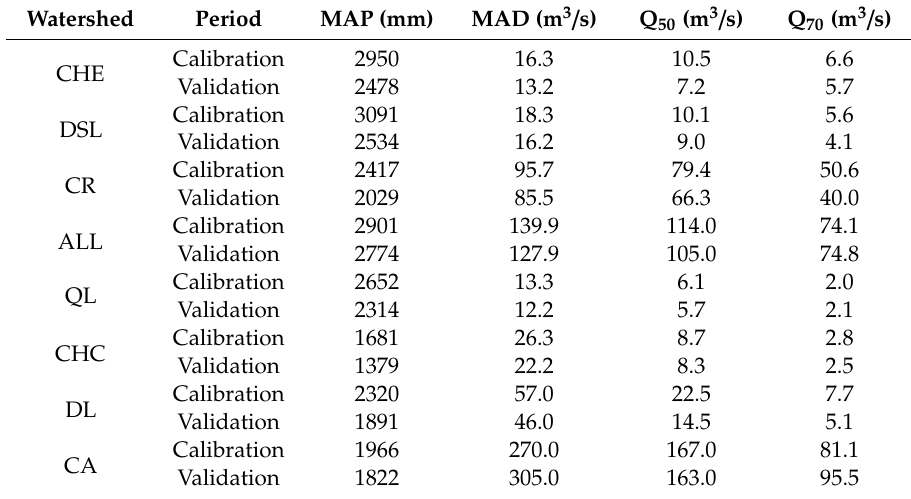
Table 4. Streamflow and corrected precipitation (corrected precipitation by a factor) statistics for the calibration and validation periods in the studied